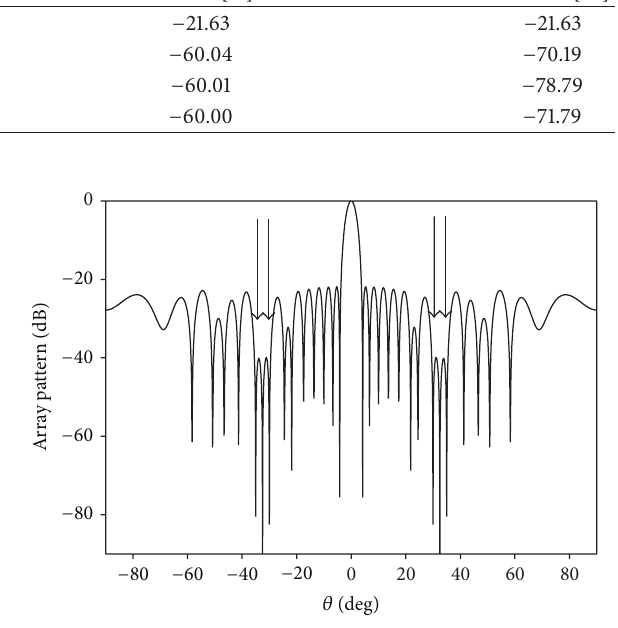
Figure 12: 22-element array pattern found by position only control with one imposed null at 9 ∘ .